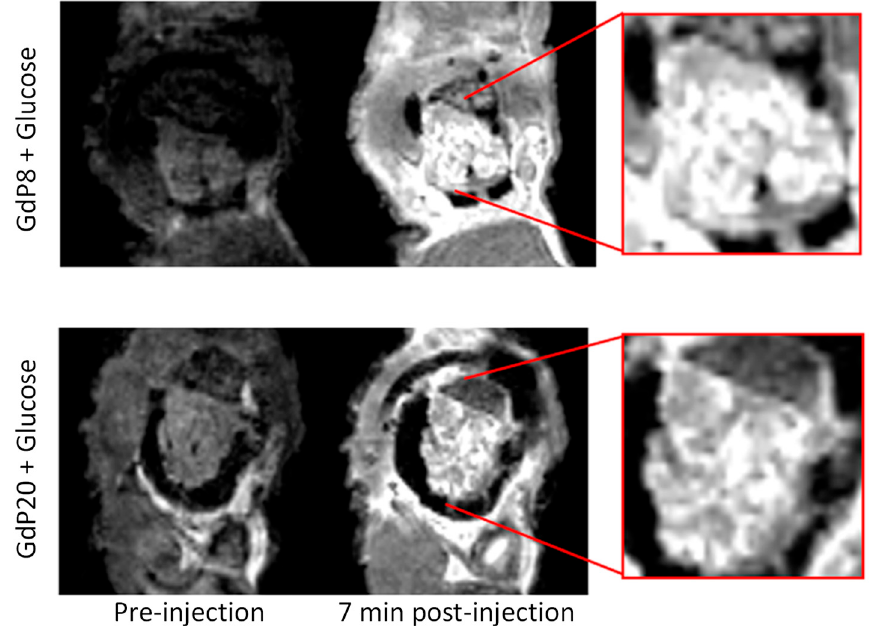
Figure 12. Three-dimensional T 1 -weighted MR images of mouse pancreas pre or post-injection of GdP8 or GdP20 plus glucose (for Zn 2+ release). Reproduced with permission from Ref [58]; published by American Chemical Society, 2018.